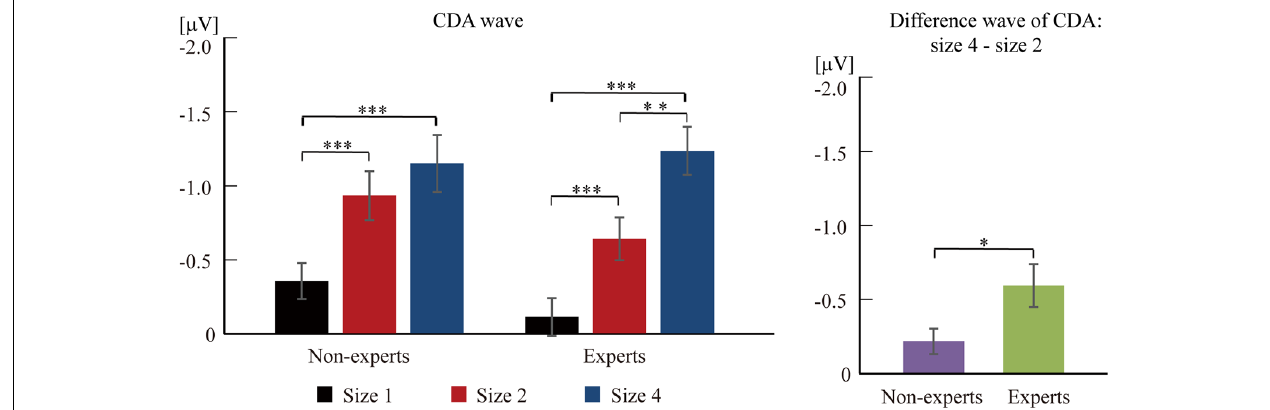
FIGURE 4 | The difference wave of contralateral delay activity (CDA) component between experts and non-experts. The CDA wave was time-locked to the memory array and averaged across the posterior electrode pairs (i.e., CP1/CP2, CP5/CP6, P3/P4, P7/P8, and O1/O2) and across 300–900 ms after the memory array onset. Error bars represent mean ± SEM in the left, after correction by Bonferroni method. ∗ p < 0.017, ∗∗ p < 0.003, ∗∗∗ p < 0.0003; in the right, ∗ p <